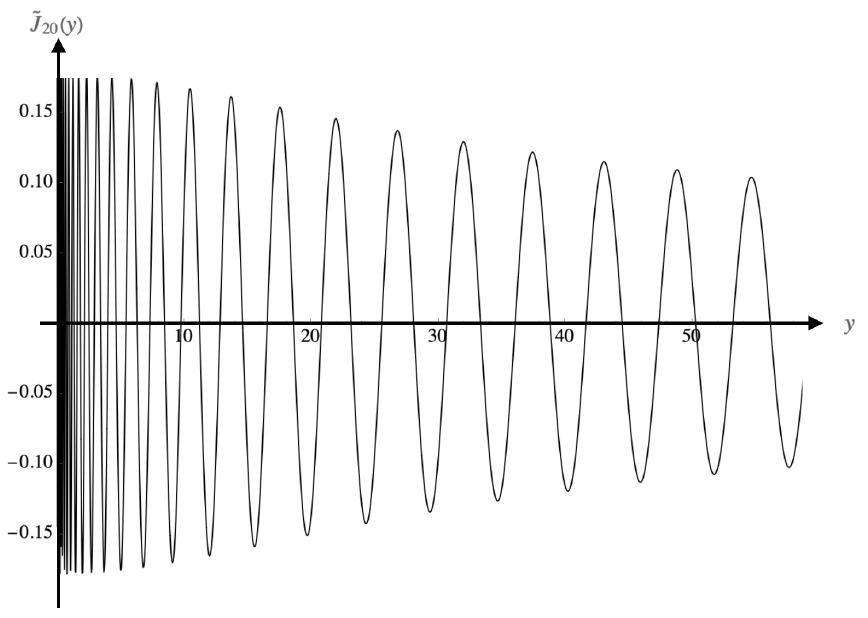
Figure 6. The Bessel function of imaginary order ˜ J 20 ( y ) . Lowering y , it displays a transition from harmonic to logarithmic oscillations near y = 20